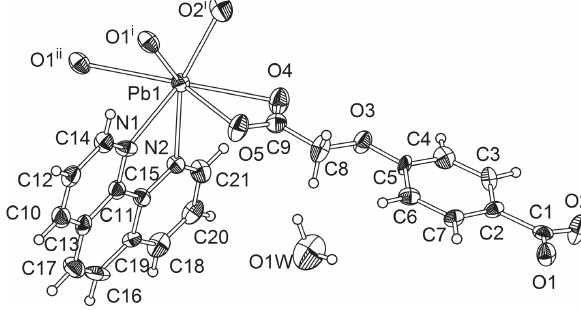
Table 1: Data collection and handling.